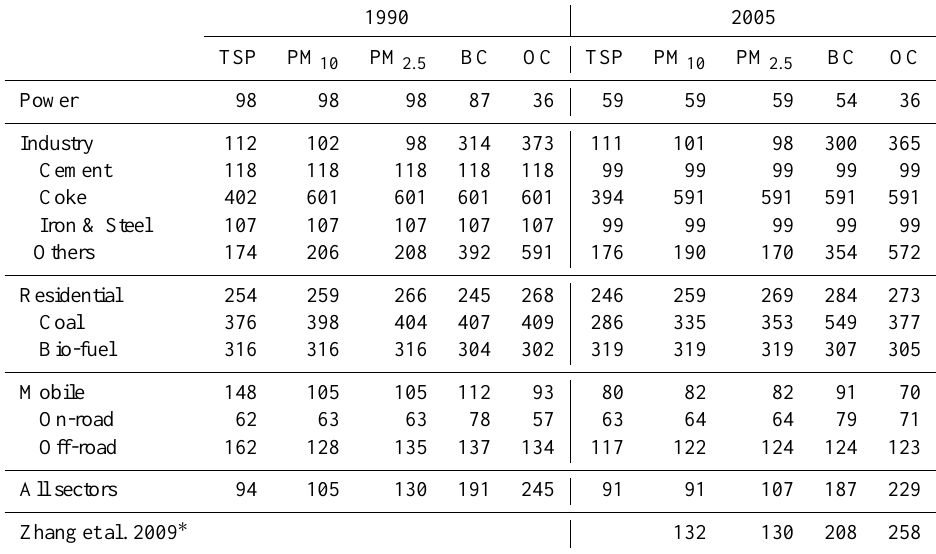
Table 10. Uncertainty in emissions estimates of TSP, PM 10 , PM 2 . 5 , BC, and OC in 1990 and 2005 ( ± 95% Confidence Intervals), numbers shown in table as